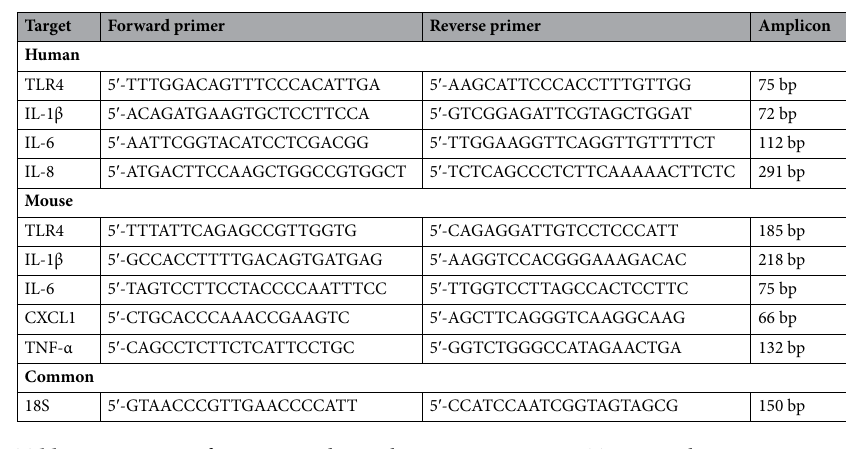
Table 1. Sequence of primers used in real-time quantitative RRT-PCR analysis.